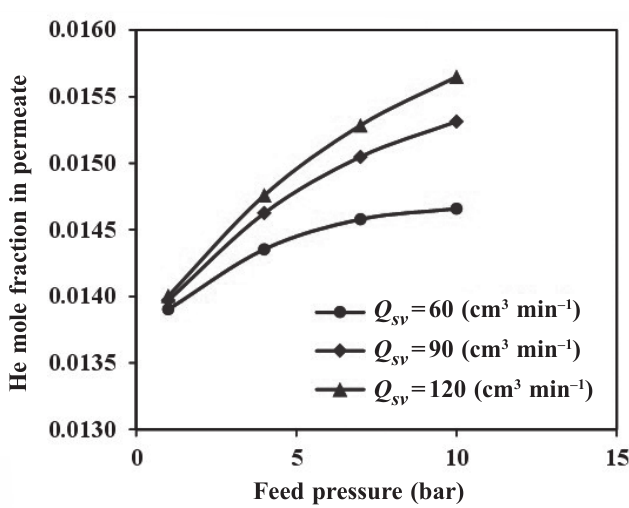
Fig. 8 – Impact of feed pressure on He mole fraction in per- meate stream at a different feed flow